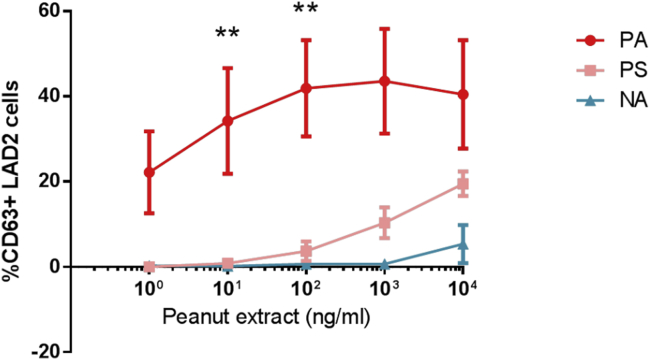
Peanut-induced activation of mast cells (expressed as a percentage of CD63+ LAD2 cells) sensitized with plasma from patients with PA (n = 6), PS patients (n = 5), and NA subjects (n = 2). Similar results were found for mast cell activation expressed as a percentage of CD107a+ LAD2 cells. Values are presented as means and SEs. P values refer to the comparison between patients with PA and PS patients for each concentration of peanut extract using the Mann-Whitney U test. **P < .01.